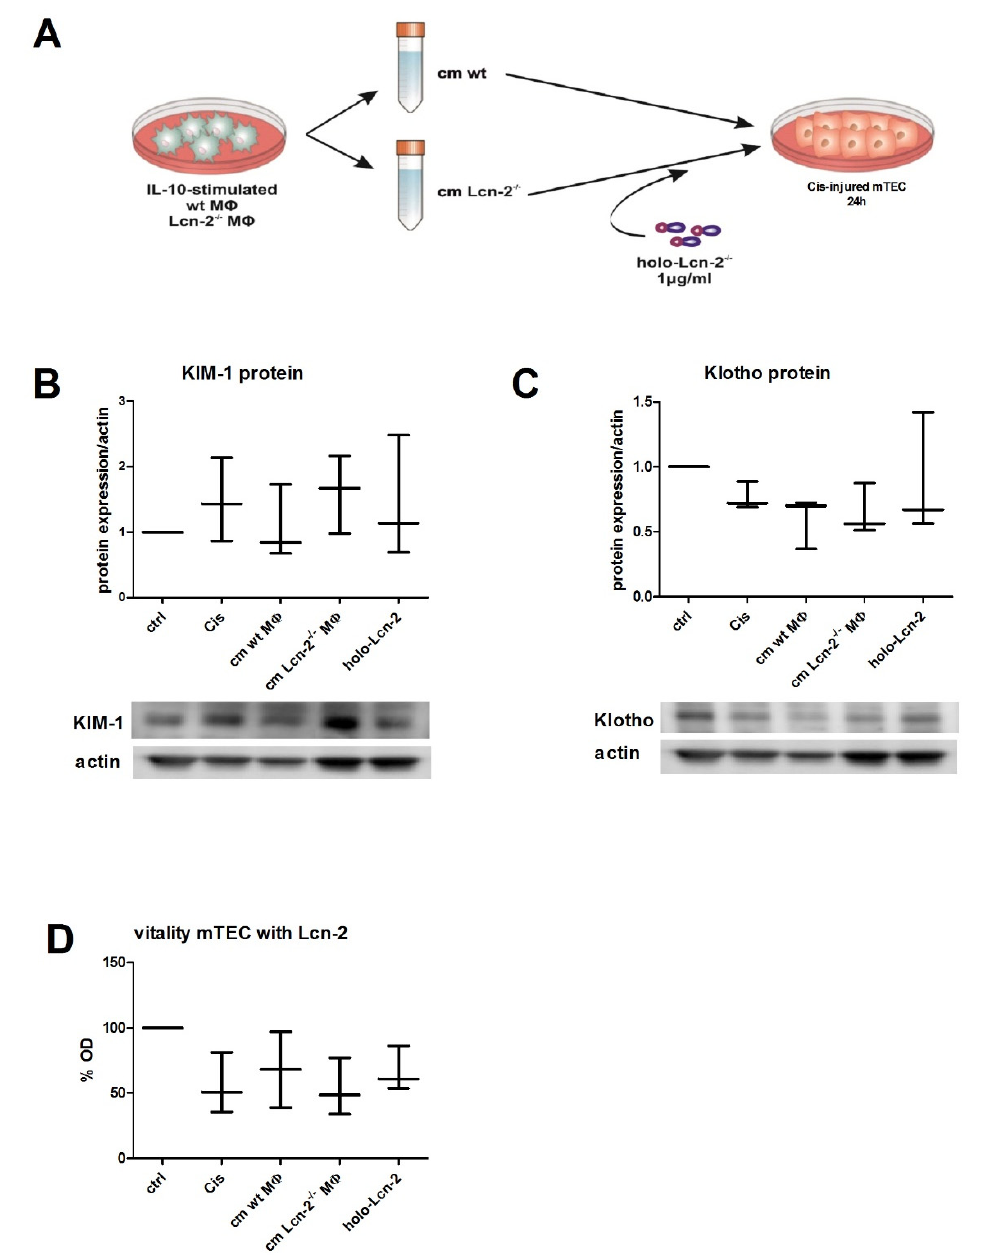
Figure 3. Cellular vitality depends on the presence of Lcn-2-bound iron in macrophage supernatants . ( A ) Visualization of the experimental set up. mTECs were either cultivated with standard medium without FCS (ctrl) or injured by 24 h incubation with 5 µ M Cisplatin (Cis). Hereafter, Cisplatin-injured mTECs were cultured 24 h further in conditioned medium from IL-10-stimulated M Φ from wt mice (wt cm) or Lcn-2 − / − mice (Lcn-2 − / − cm). The latter group was further cultivated with supplementation of iron-containing holo-Lcn-2 (designated as Lcn-2 − / − cm + holo-Lcn-2). ( B ) Kidney injury molecule 1 (KIM-1) (44kDA) and ( C ) Klotho (130kDA) protein expression relative to β -actin (ns; n = 3). ( D ) Measurement of cellular vitality after cm-treatments via XTT (ns; n =